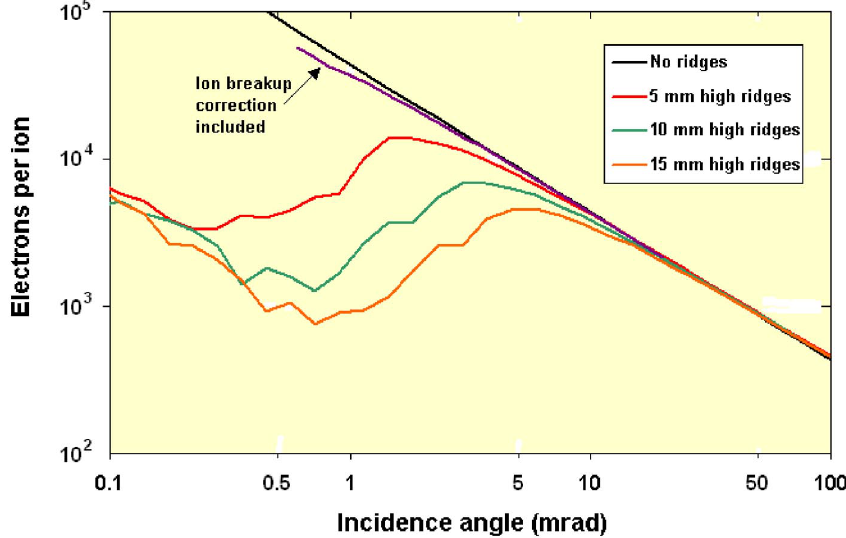
FIG. 12. (Color) Electron yields for 9 : 6 GeV = amu gold ions incident on stainless steel with ridges placed at 5 m intervals. Desorption rates will follow similar patterns.